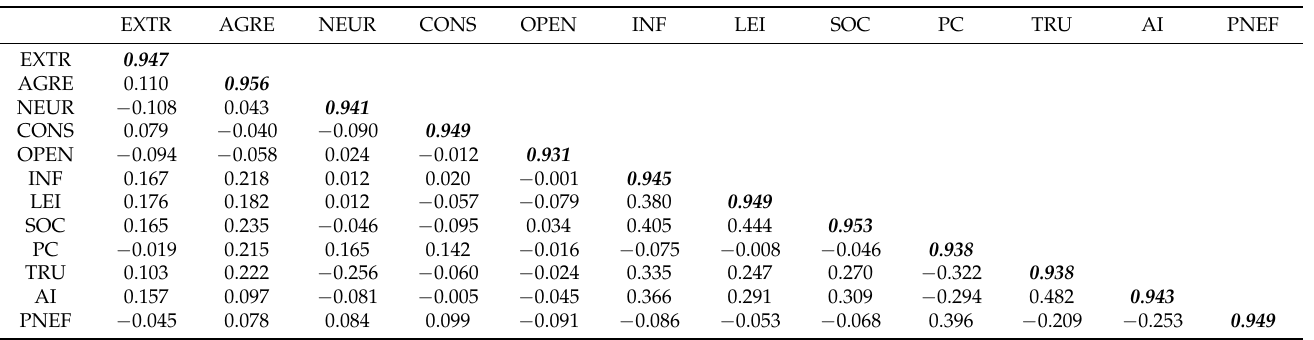
Table 4. Correlation coefficients and square root of